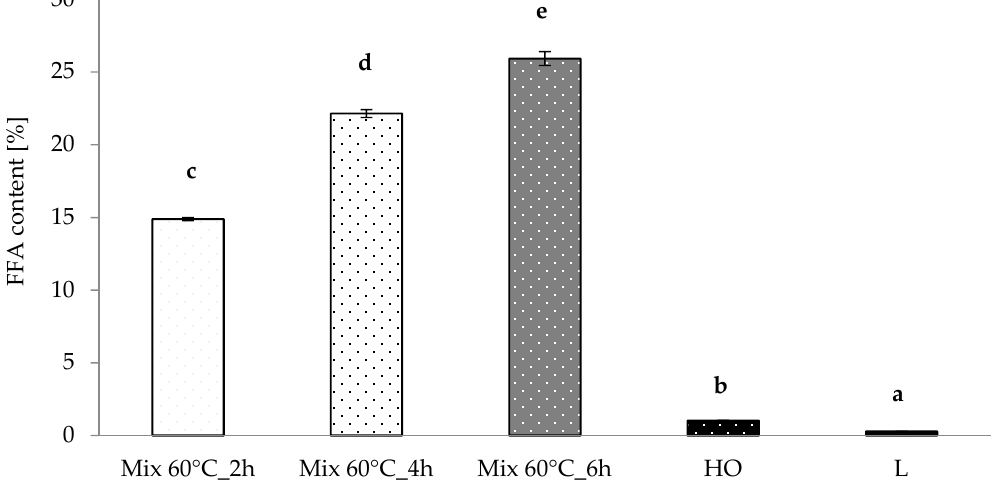
Figure 3. Free fatty acid (FFA) contents (wt%) in lard (L), hemp seed oil (HO), and human breast milk fat substitutes. Different letters indicate that the samples are significantly different at p < 0.05.